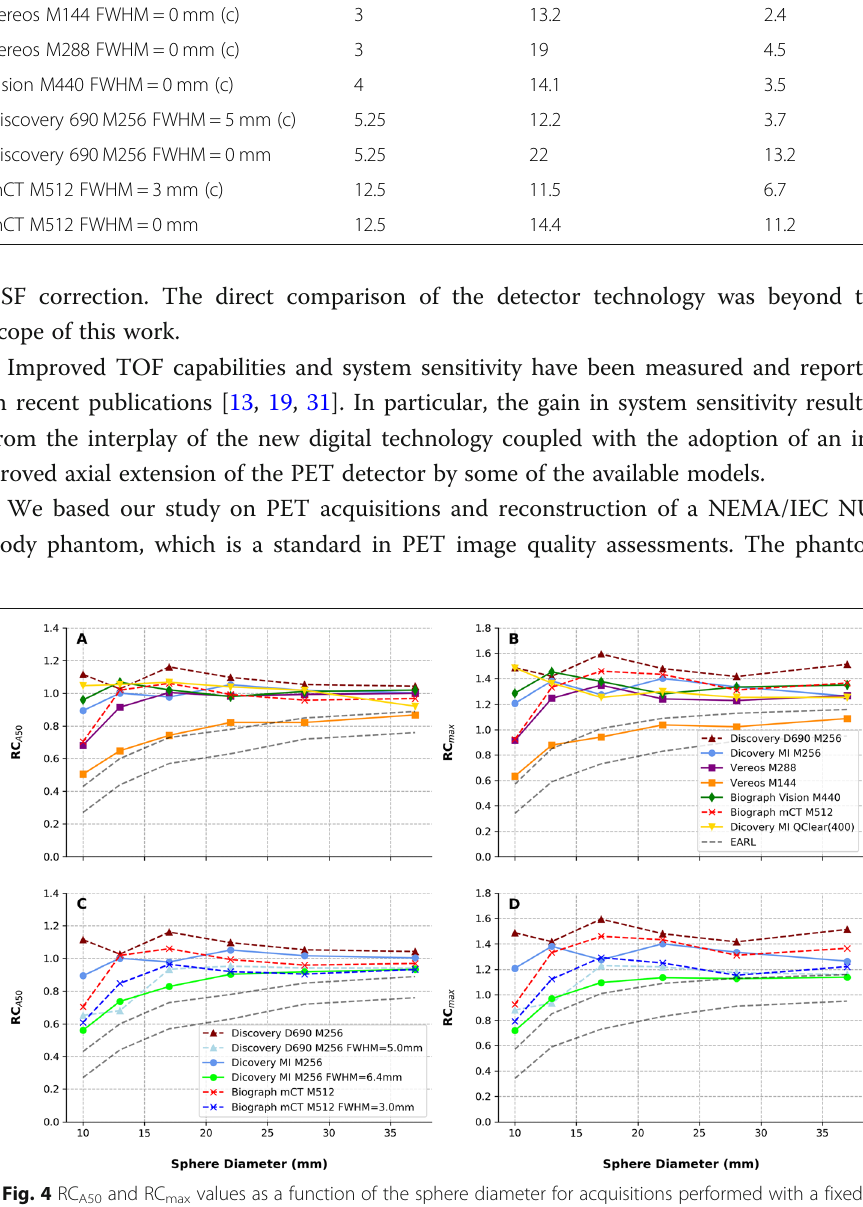
Table 3 Clinical TAP (TAP clinic ), COV values obtained for clinical TAP values, characteristic of tested 18 F-FDG PET procedures, and TAP computed for a 15% COV level (TAP protocol setups used in the clinic are labeled with (c) PET device/recon. procedure